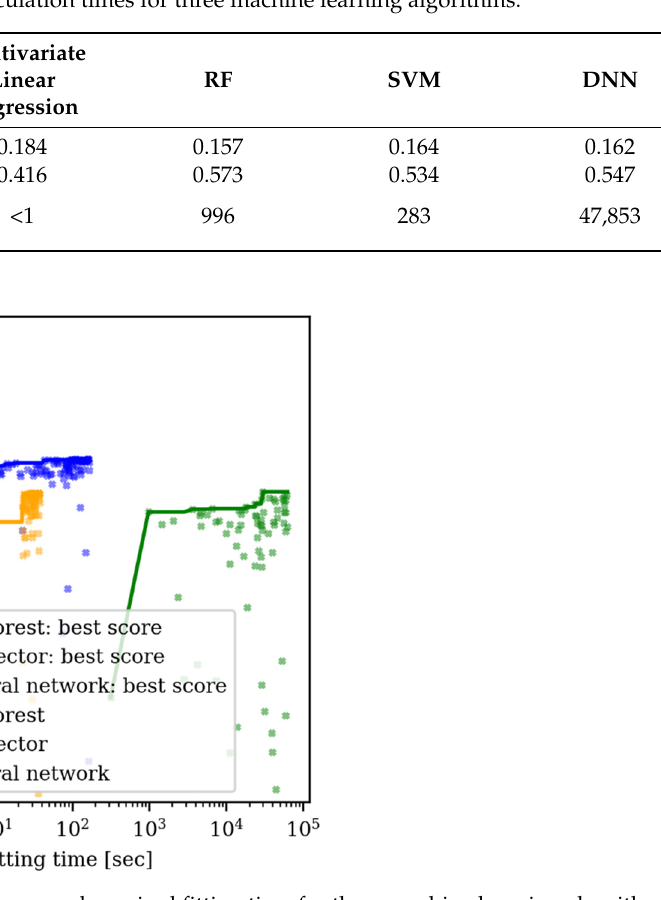
Table 7. Test scores and calculation times for three machine learning algorithms.